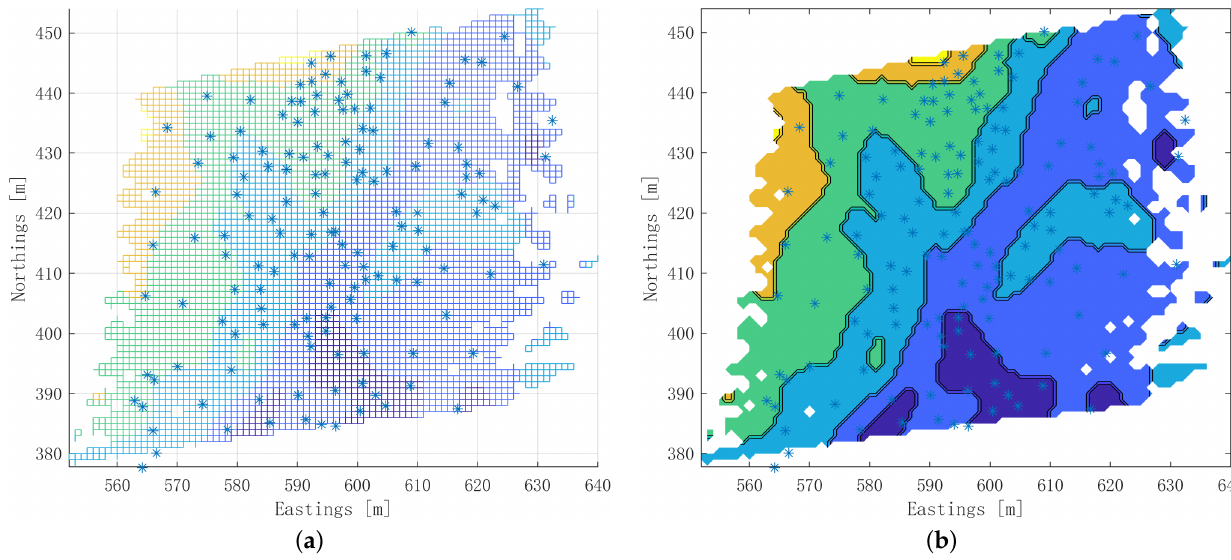
Figure 5. Sparse pseudo-input Gaussian processes (SPGPs) method. ( a ) A representation of the test map as SPGPs map. ( b ) Contour map generated from the SPGPs map (Figure